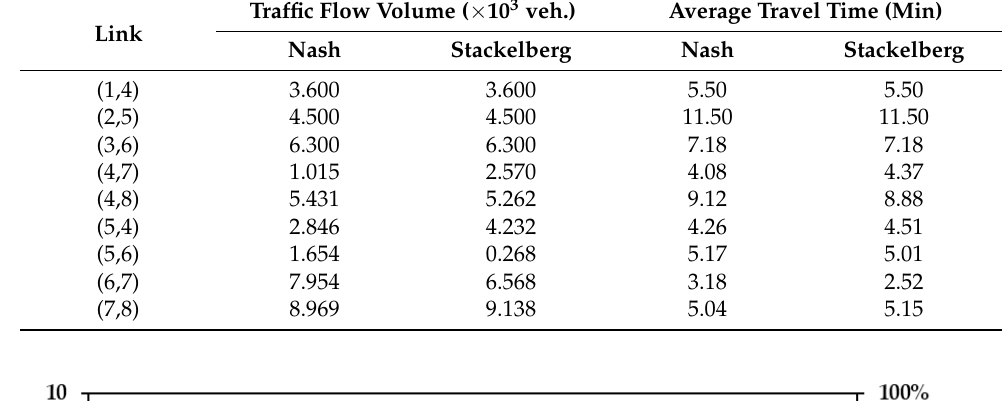
Table 7. Results of optimization with the Nash and Stackelberg approaches for road network links in scenario #2.